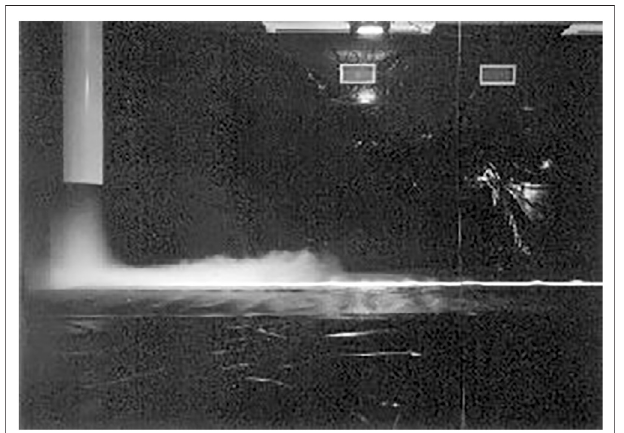
FIGURE 13 | Impinging jet ventilation. FIGURE 14 | Personalized ventilation. The distance s is typically about